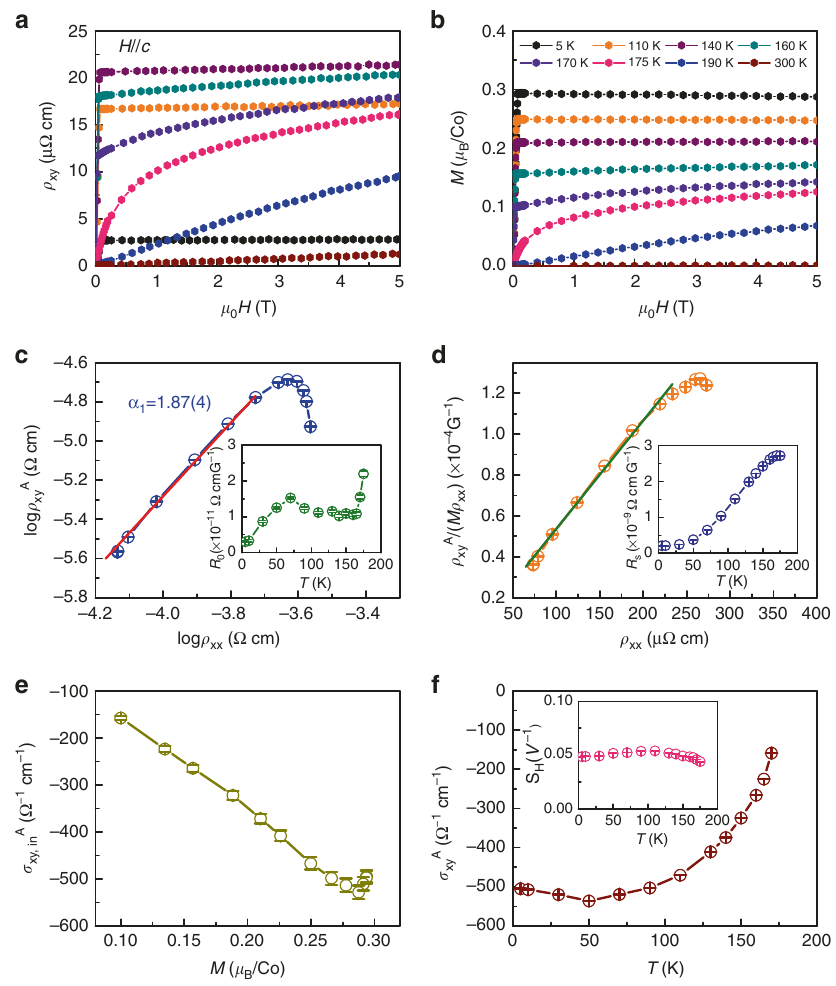
Fig. 4 AHE of Co 3 Sn 2 S 2 . a , b Hall resistivity ρ xy ( μ 0 H ) and M ( μ 0 H ) as a function of magnetic fi eld at various temperatures for H || c , respectively. c Plot of log ρ A ð T Þ vs. log ρ xx ( T ). The red solid line is the fi t using the relation ρ A xy ρ ≤ 250 μΩ cm. Insets of c and d show the temperature dependence of R xx f AHC σ A xy ð T Þ as a function of temperature. Inset: temperature dependence of scale factor S H ( T ). Error bars in c – f are the standard deviations of the fi ts when determining the ρ A xy (Supplementary Note